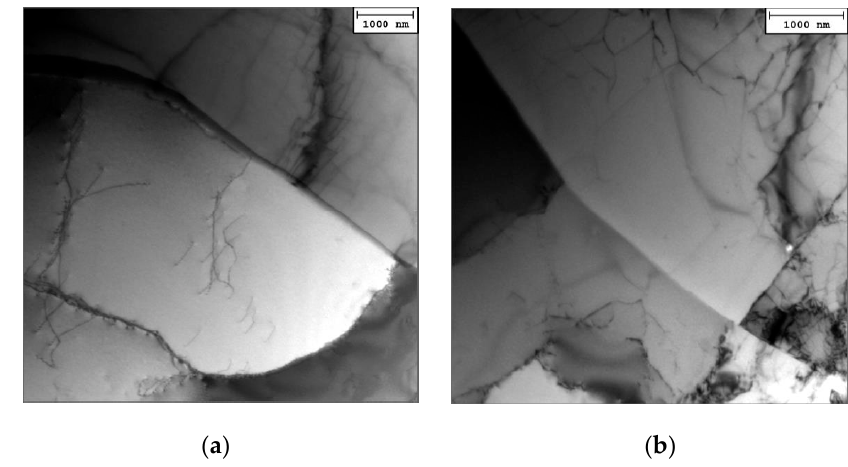
Figure 8. Aluminum specimen of 10 µm thickness. TEM observations of the grain and dislocation structure. (a) and (b) refers to different regions of the same specimen.